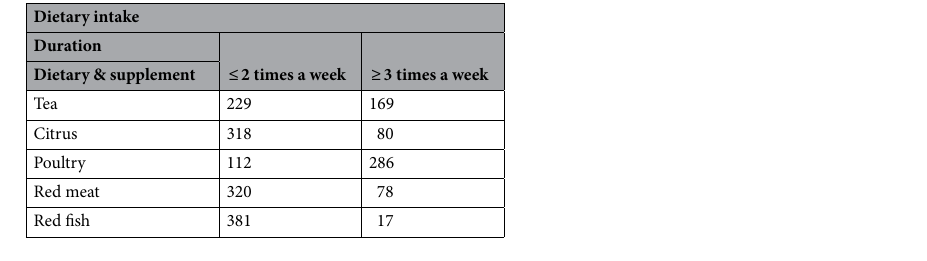
Table 4. Rate of dietary intake of tea, citrus, poultry, red meat and red fish among the participants.